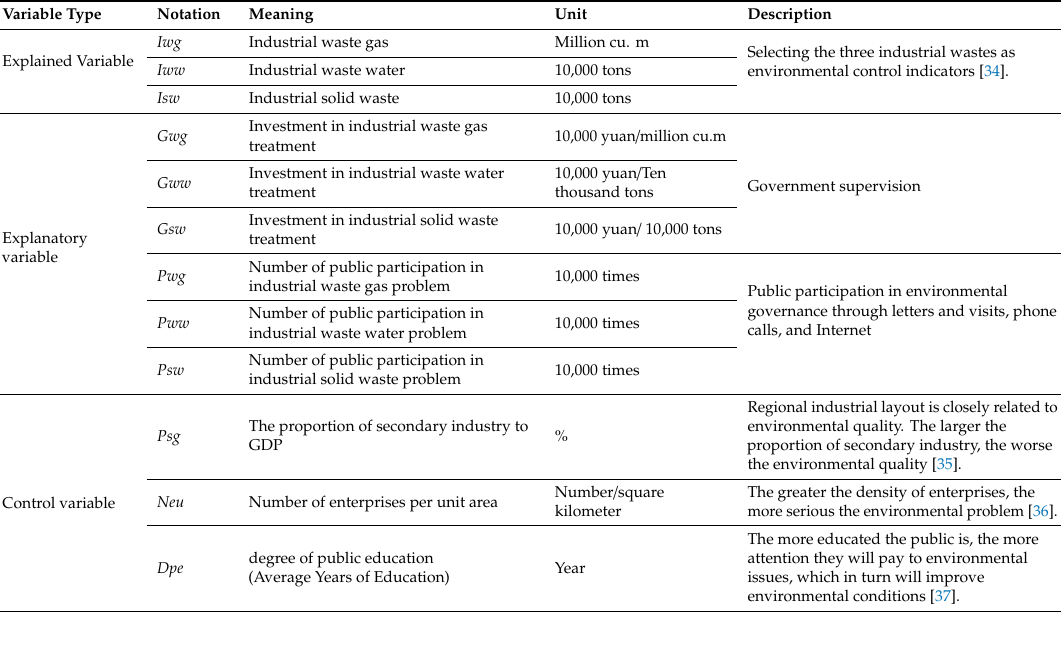
Table 4. Variables and